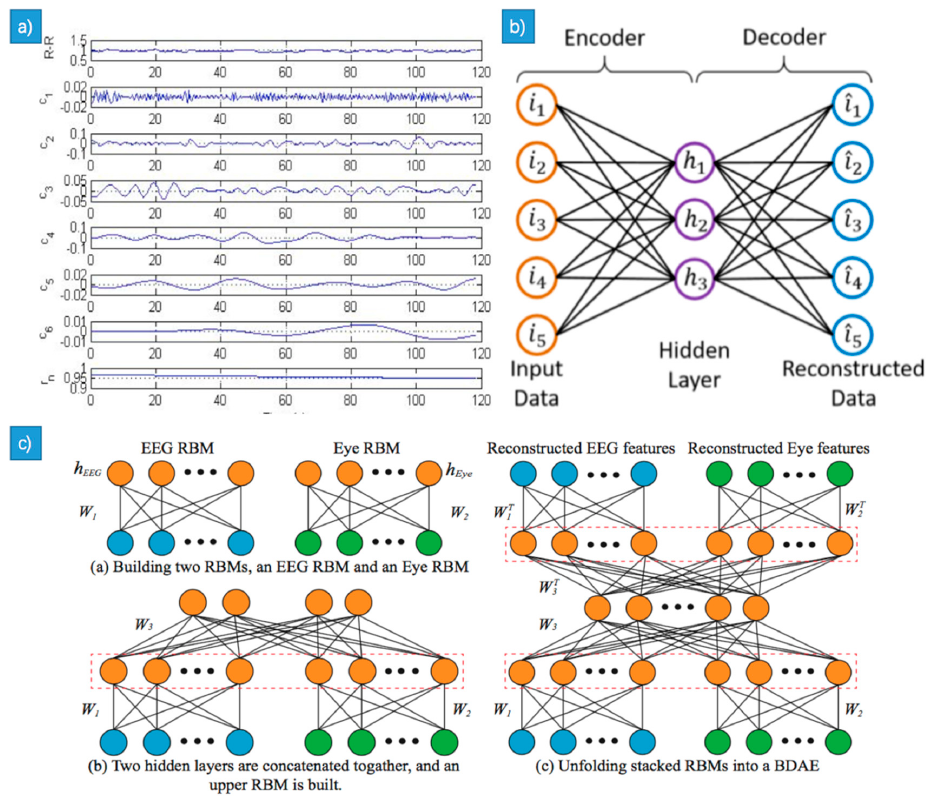
Figure 11. ( a ) The decomposition of R-R interval signal (emotion of sadness); ( b ) The structure of Autoencoder; ( c ) The structure of Bimodal Deep AutoEncoder. Autoencoder; ( c ) The structure of Bimodal Deep